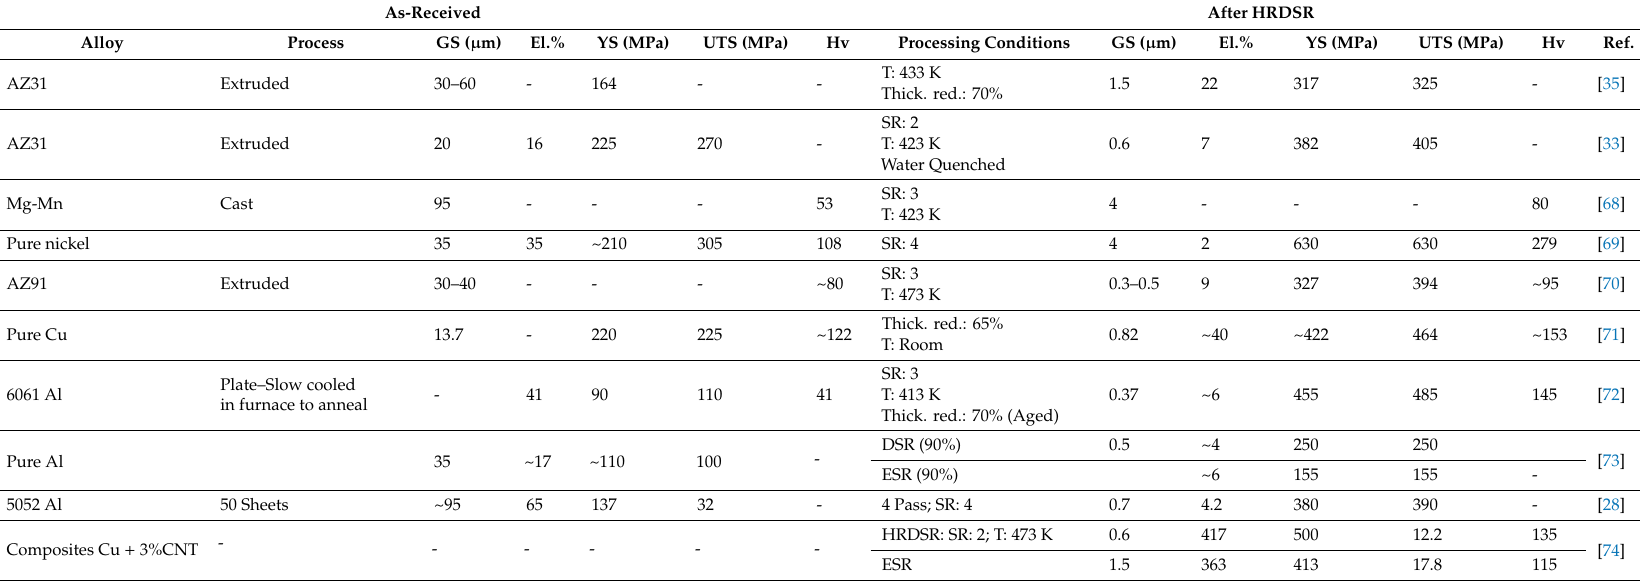
Table 1. Literature review of the mechanical properties of various alloys subjected to HRDSR compared to the as-received samples. Here, GS is the grain size, El., YS and UTS are the tensile elongation, yield strength and ultimate strength, respectively, and Hv is the Vickers